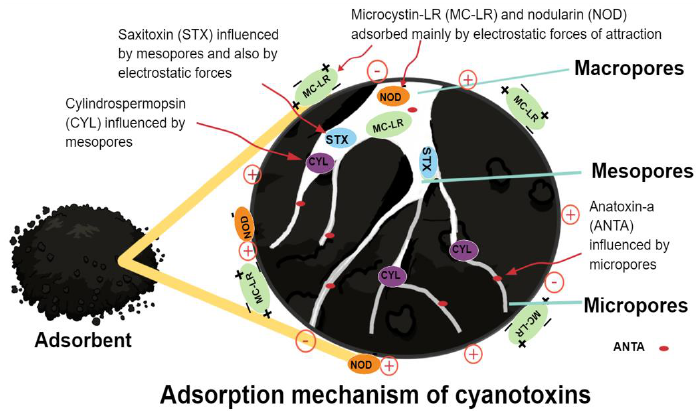
Figure 2. Adsorption mechanisms between cyanotoxins and adsorbent materials.